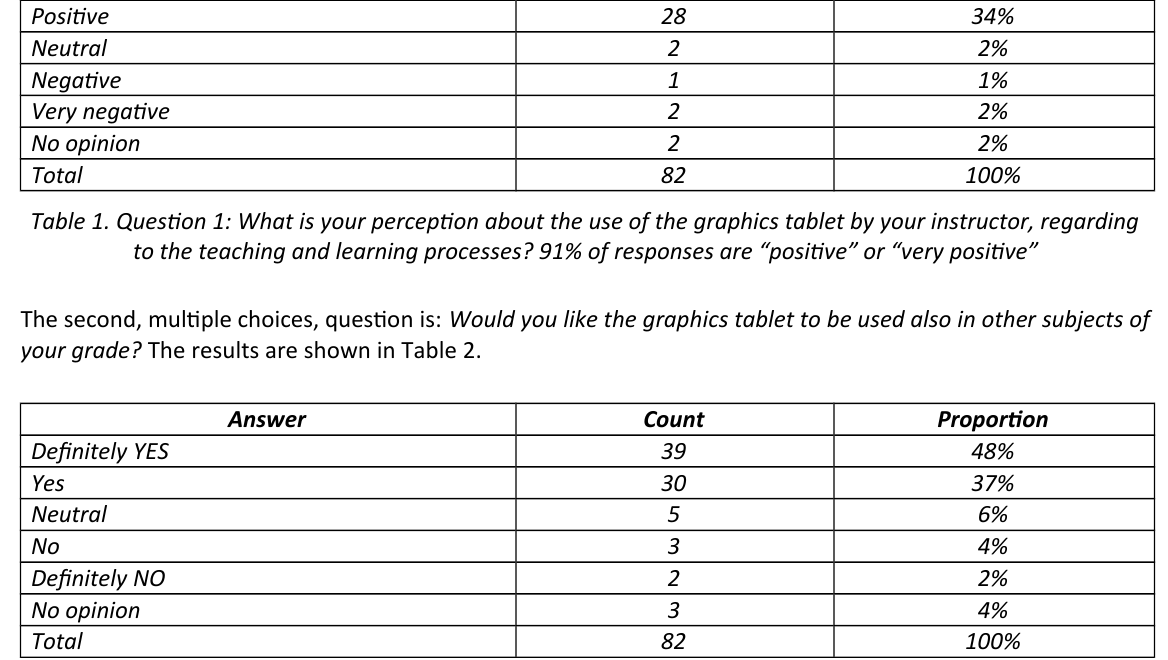
Table 2. Queston 2: Would you like the graphics tablet to be used also in other subjects of your grade? 85% of responses are “positve” or “very